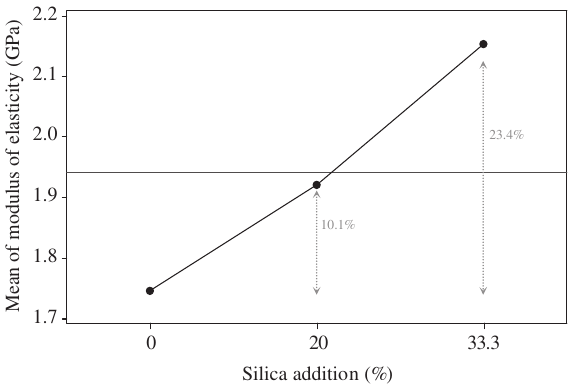
Figure 6 Main effect plot of ‘silica addition’ for modulus of elasticity